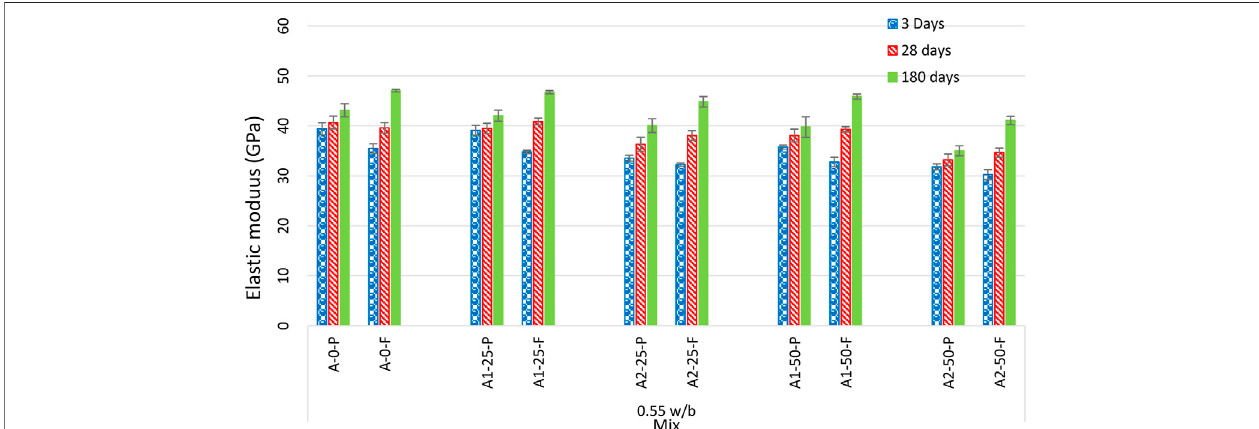
FIGURE 8 | Elastic modulus of 0.55 w/b concrete mixes.